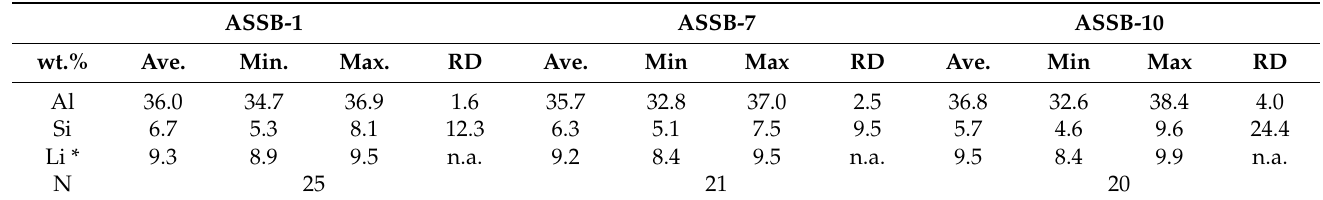
Table A1. Composition of LiAl (wt.%) based on single-point analysis. Ave.: arithmetic average; Min./Max.: lowest/highest measured values; RD: relative standard deviation (%); N: number of measurements; n.a. not applicable (calculated values), * calculated value.